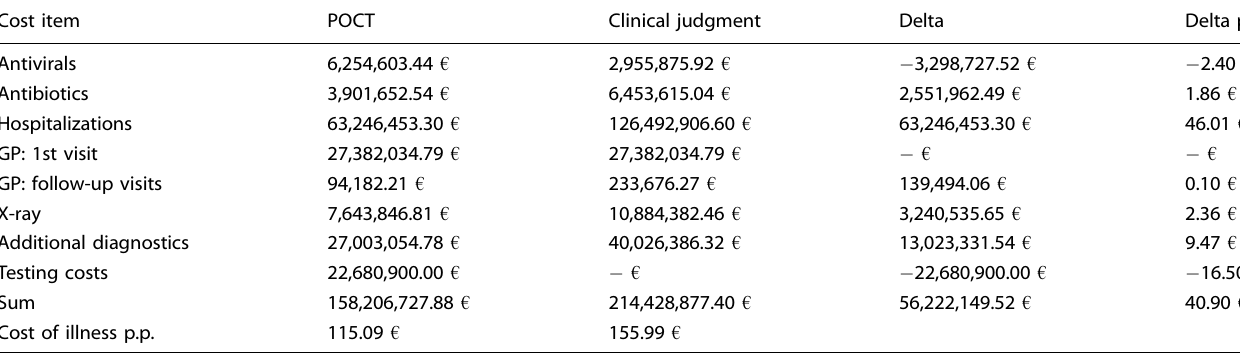
Table 7. Calculation (age-group speci fi c) elderly people.